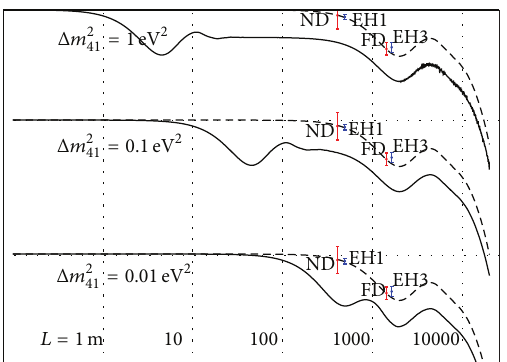
Figure 1: The dependency of ⟨𝑃⟩ in (5) on Δ𝑚 2 41 is presented, when = 2.32 × 10 −3 eV 2 as taken in RENO and Daya Bay. Typical Δ𝑚 2 31 shapes of ⟨𝑃⟩ versus distance are drawn for comparison with the measured ratios in the two experiments. The amplitudes of Δ𝑚 2 31 oscillation and Δ𝑚 2 41 oscillation are given by sin 2 2𝜃 13 = 0.10 and sin 2 2𝜃 14 = 0.10 , respectively, as an